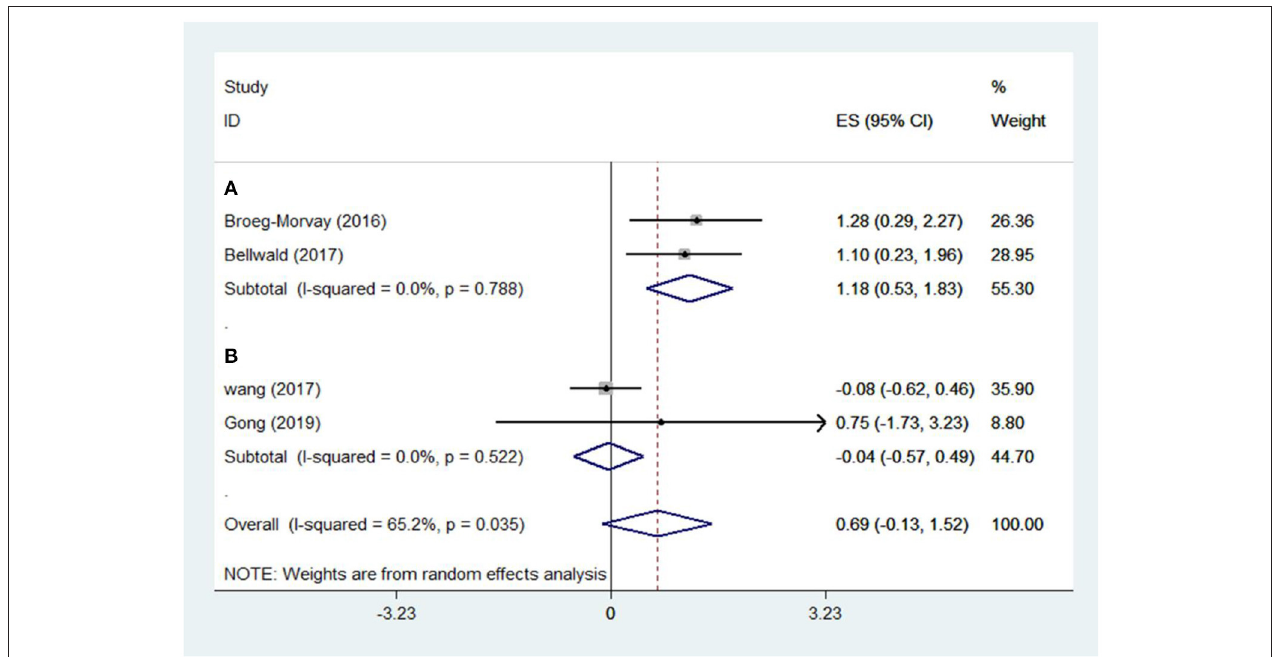
FIGURE 6 | Adjusted mortality at 90 days. (A) Age > 70 years; (B) age ≤ 70 years. ES , effect size.